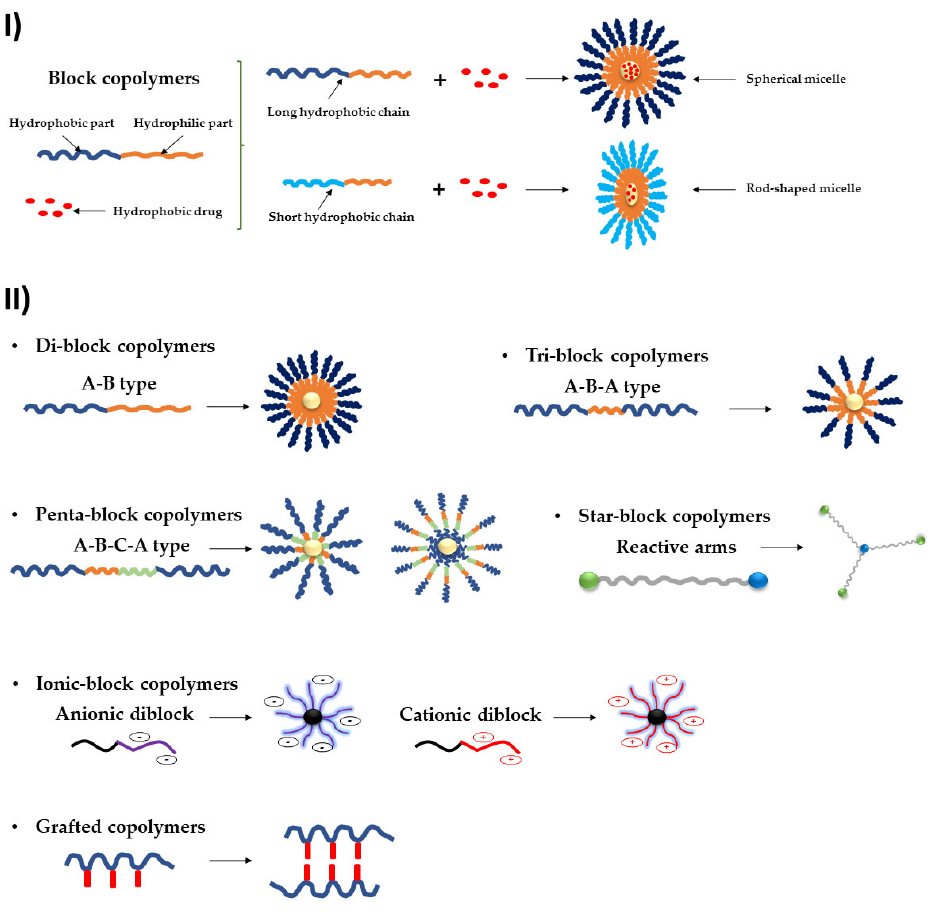
Figure 2. The structure of polymeric micelles. ( I ) Block polymers forming different shaped polymeric micellar systems. ( II ) Example of different block copolymers. Pharmaceutics 2023 , 15 , x FOR PEER REVIEW